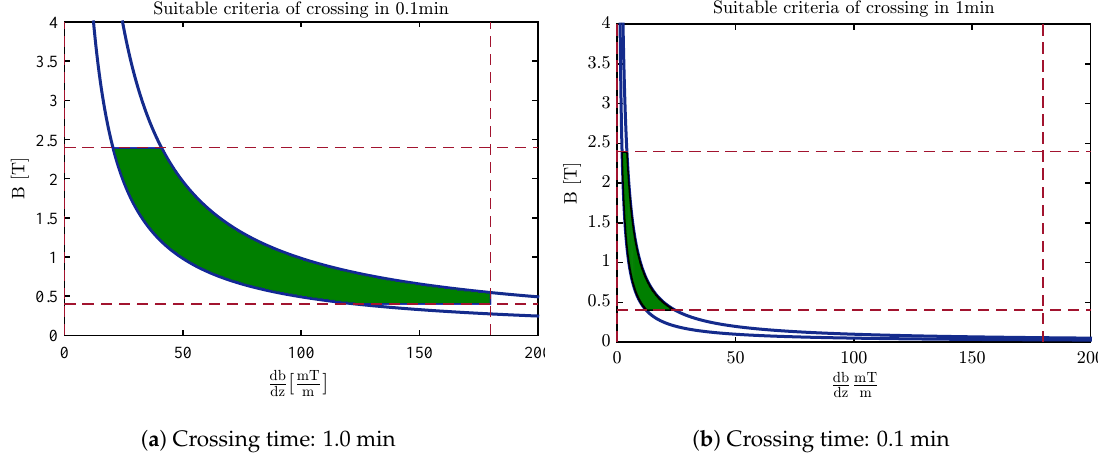
Figure 10. The desired area for selecting the magnetic field and magnetic gradients of